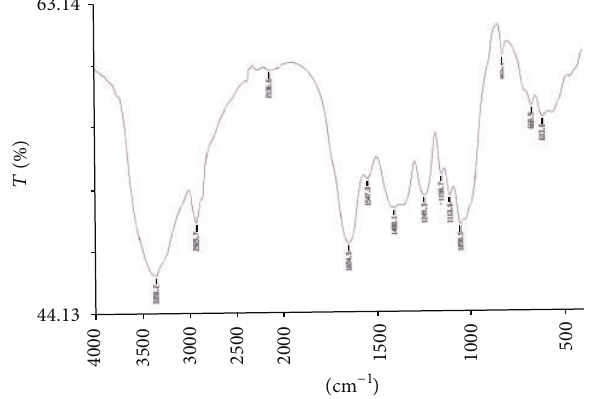
Figure 9: FTIR spectra of +PO 4 (DDP) treated biomass showing different functional groups. The “ 𝑥 ” axis of the spectra denotes wavenumber (cm −1 ) and “ 𝑦 ” axis denotes transmittance (% 𝑇 ).